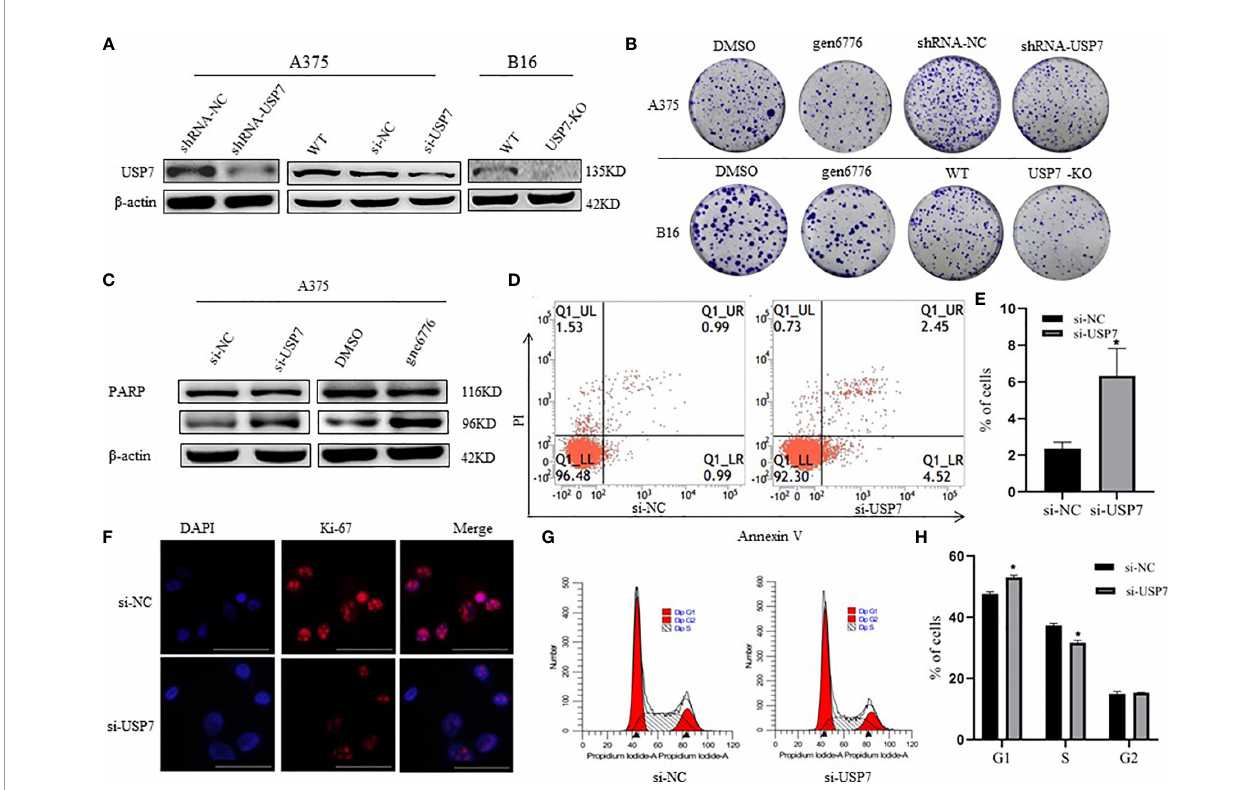
FIGURE 2 | Effects of USP7 on melanoma cell line growth. (A, B) Protein lysates were extracted from A375 cells transiently expressing USP7 siRNA and stable control shRNA or USP7 shRNA and B16 cells deleted the USP7 gene using the CRISPR/Cas9 editing system (USP7 KO). Western blotting analysis was performed to determine the expression of USP7. (B) Cells were collected from the indicated cells with gen6776 (USP7 inhibitor), USP7 shRNA or USP7 knockout treatment. Colony formation assay was performed and representative images are shown. (C – E) A375 cells were transfected with USP7 siRNAs for 48 h and detected with Annexin V-FITC/PI staining followed by fl ow cytometry analysis. Cell death populations are shown. Western blotting analysis was used for PARP expression. (F – H) A375 cells were treated as described in (C – E) . Immuno fl uorescence staining of Ki-67 of A375 cells was observed using fl uorescence microscope. Red: Ki-67; blue: nucleus. Typical images are shown. Scale bars: 50 m m. Analysis of cell cycle by FCM is described in the Materials and Methods . Data are represented as the mean ± SEM of three independent experiments, each in triplicate; bars, SEM. *P ≤ 0.05 vs.